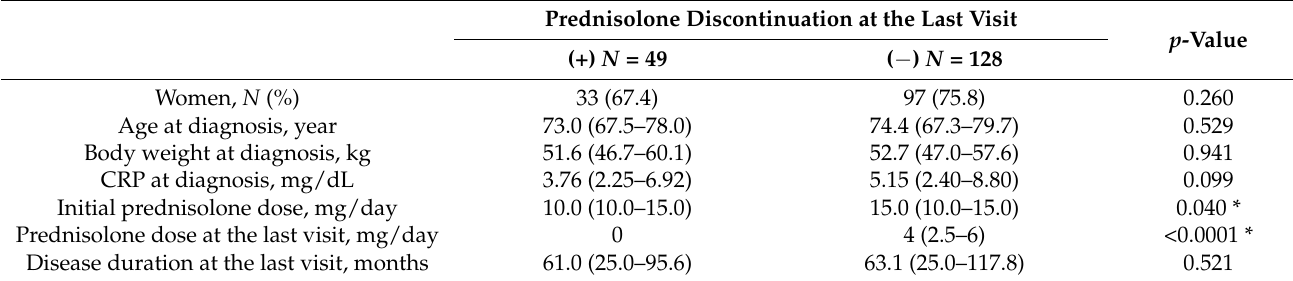
Table 4. Patient characteristics in the prednisolone group stratified according to prednisolone discontinuation at the last visit.